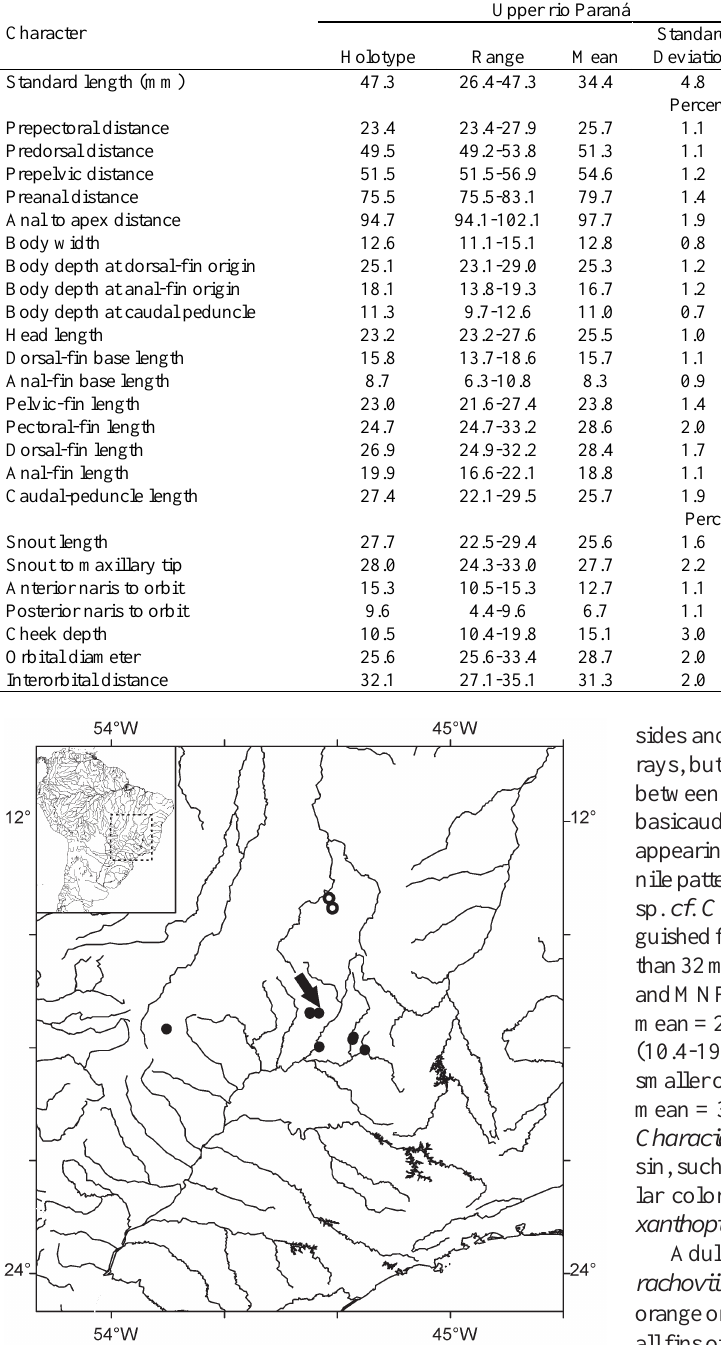
Fig. 3. Map of central Brazil, showing distribution of Characidium xanthopterum . Arrow indicates type-locality (Caldas Novas, Goiás State, upper rio Paraná basin), com- plete circles represent localities in the upper rio Paraná basin, and open circles represent localities in the upper rio Tocantins basin. Symbols may represent more than one lot or locality.